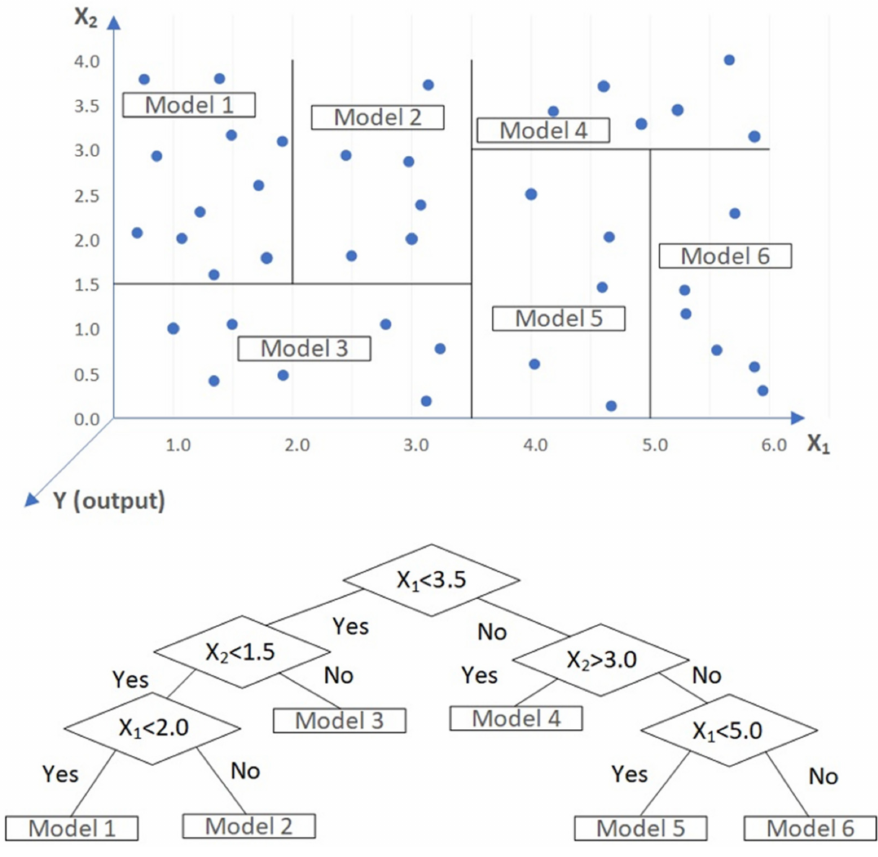
Figure 1. An example of a typical Model Tree (adapted from